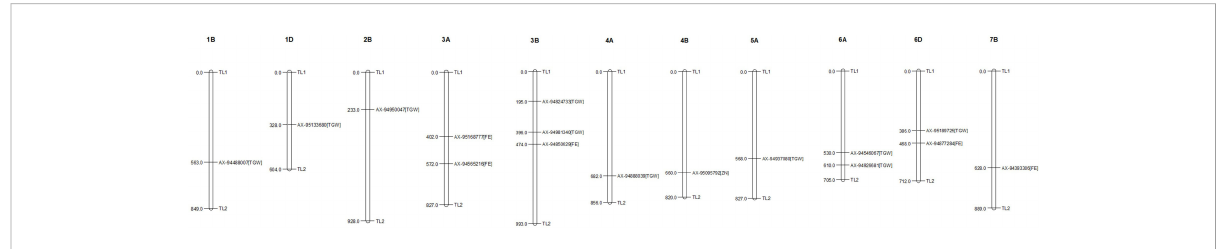
FIGURE 9 Distribution and position (in Mb) of identi fi ed marker trait associations (MTAs) at their respective chromosome with associated